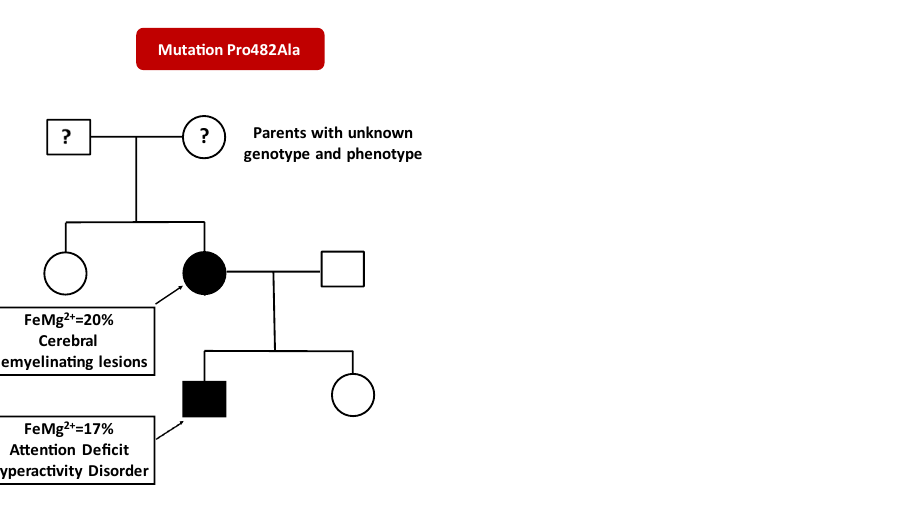
Figure 1. Family tree depicting magnesium fractional excretion (FeMg 2+ ) and main clinical charac- teristics of affected individuals. Black symbols, affected individuals. White symbols, unaffected in- dividuals.